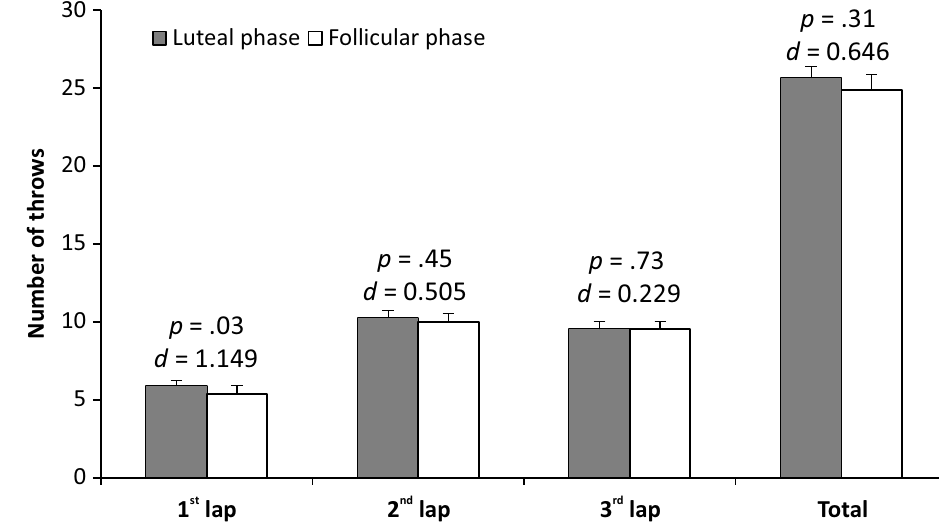
Figure 1. Mean values for number of throws in individual laps and total after performing SJFT in luteal and follicular phase of menstrual